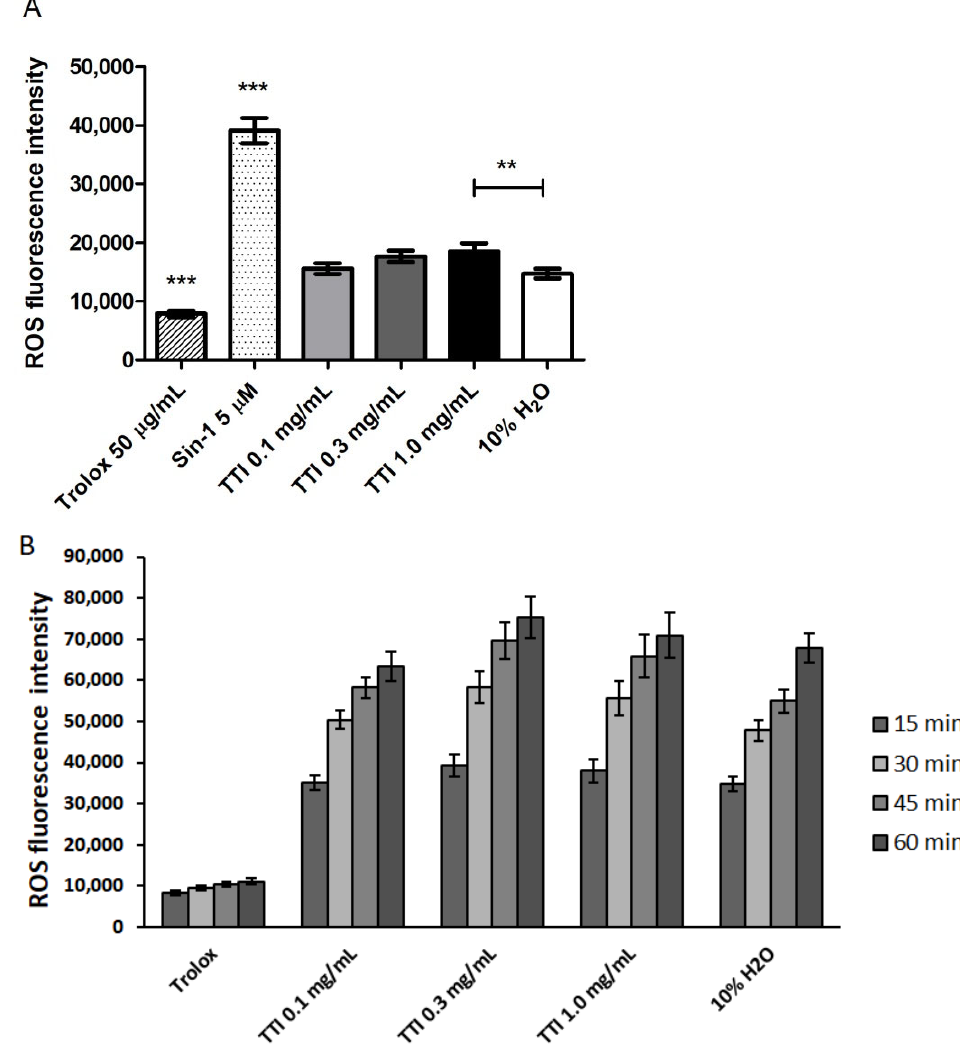
Figure 5. Effect of TTI on basal level of ROS at different concentrations ( A ) after incubation for 4 h with differentiated co ‐ cultures of Caco ‐ 2:HT29 ‐ MTX cells and ( B ) after additional stress with Sin ‐ 1 5 μ M, to evaluate the anti ‐ inflammatory potential of the samples. Trolox (50 μ g/mL) and Sin ‐ 1 (5 μ M) were used as negative and positive controls, respectively. H 2 O diluted in HBSS (10% v / v ) was used as a control of the treatments. ** p < 0.01; *** p < 0.001, compared to the other groups (one ‐ way